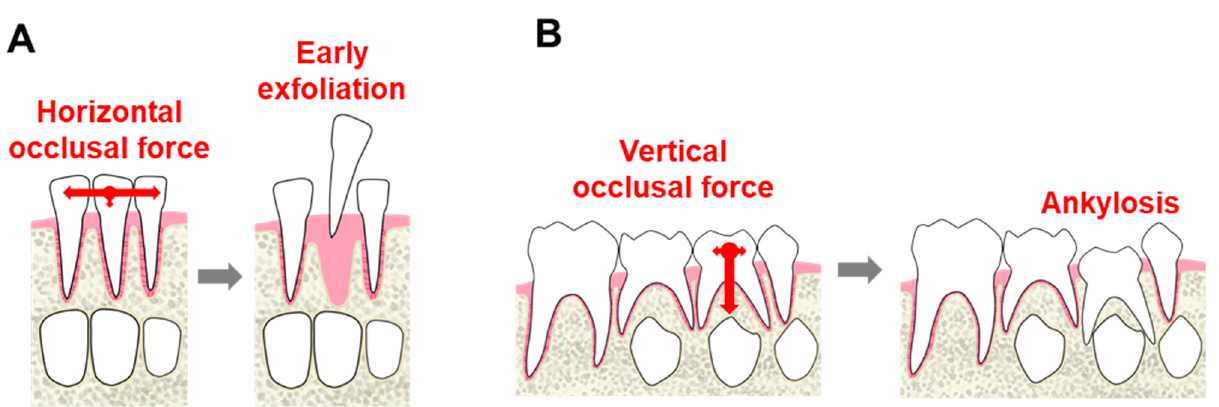
Figure 3. Possible mechanism of ankylosis. ( A ) In anterior teeth, lateral force may be greater than vertical force and lateral force can promote exfoliation of teeth; ( B ) Occlusal force acts vertically in molars and may resist exfoliation involved in ankylosis.